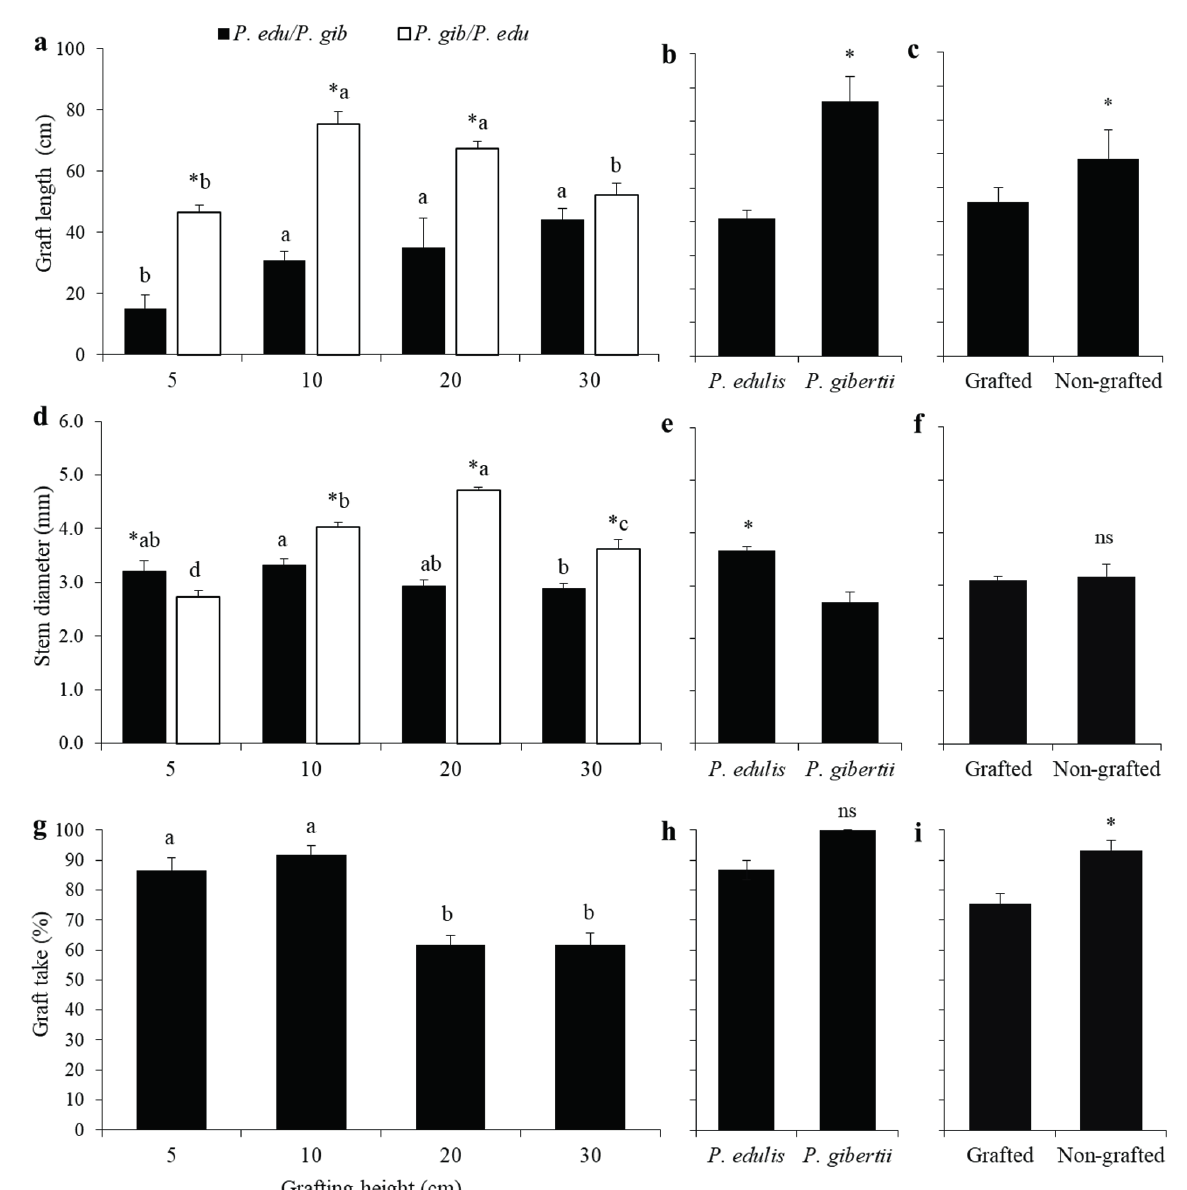
Figure 3 - Biometric variables of Passiflora edulis grafted on P. gibertii their reciprocal grafting ( P. gibertii/P. edulis ) non-grafted P. edulis and P. gibertii plants and the grafted plants and non-grafted plants. ( a-c ): graft length. ( a ) scion-rootstock combination x grafting height. ( b ) comparison between non-grafted plants and ( c ) comparison between grafted and non-grafted plants. ( d-f ): stem diameter. ( d ) scion-rootstock combination x grafting height. ( e ) comparison between non-grafted plants and ( f ) comparison between grafted and non-grafted in general. ( g ) graft take as a function of grafting height of P. edulis/P. gibertii. ( h ) plant survival (%) of the non-grafted plants and ( i ) survival between grafted and non-grafted plants. Error bar = standard error of the mean different letters indicate significant differences by the Tukey test (p ≤ 005). * Indicates significant difference by the F-test (p ≤